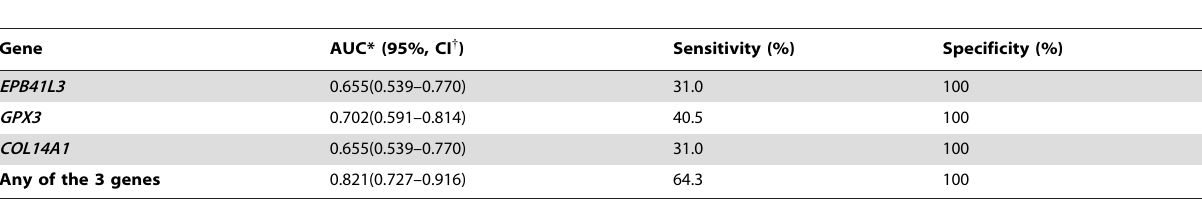
Table 7. Diagnostic Information of Plasma DNA Methylation of Individual